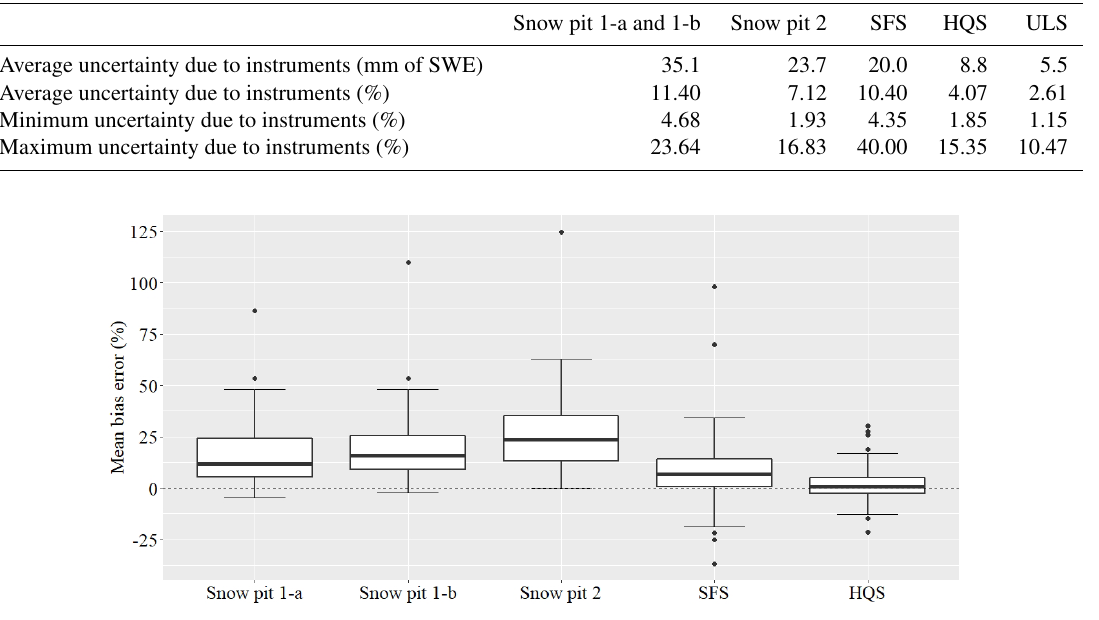
Figure 4. Mean bias error of the different SWE measurement methods relative to the ULS, which was used as the SWE reference. The value above each boxplot is the average MBE for each method. Boxes represent 25th and 75th percentiles. Bars inform of the lowest and highest quartiles, excluding the outliers represented by the dots. The middle line in each box shows the median of the data.